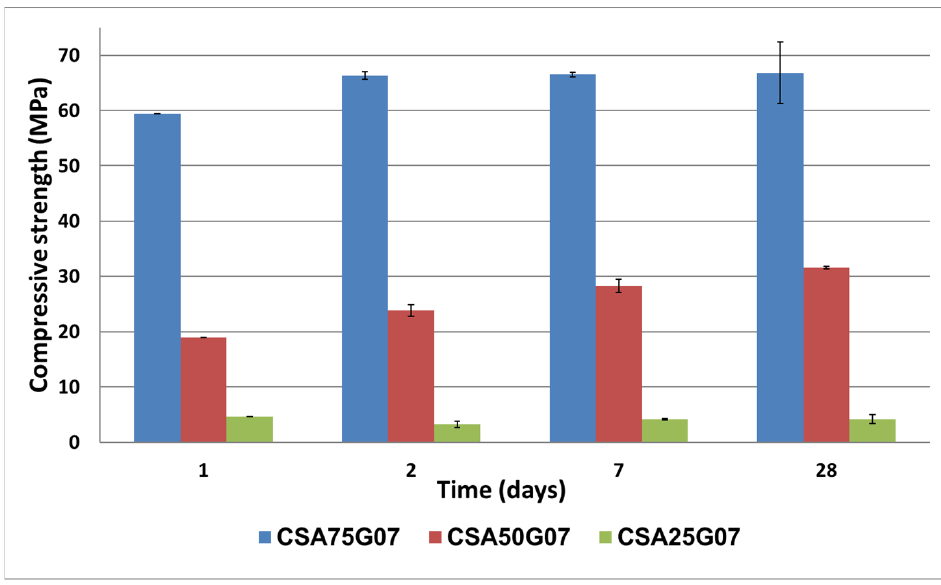
Figure 6. Compressive strength of cement pastes obtained after 1, 2, 7, and 28 days of